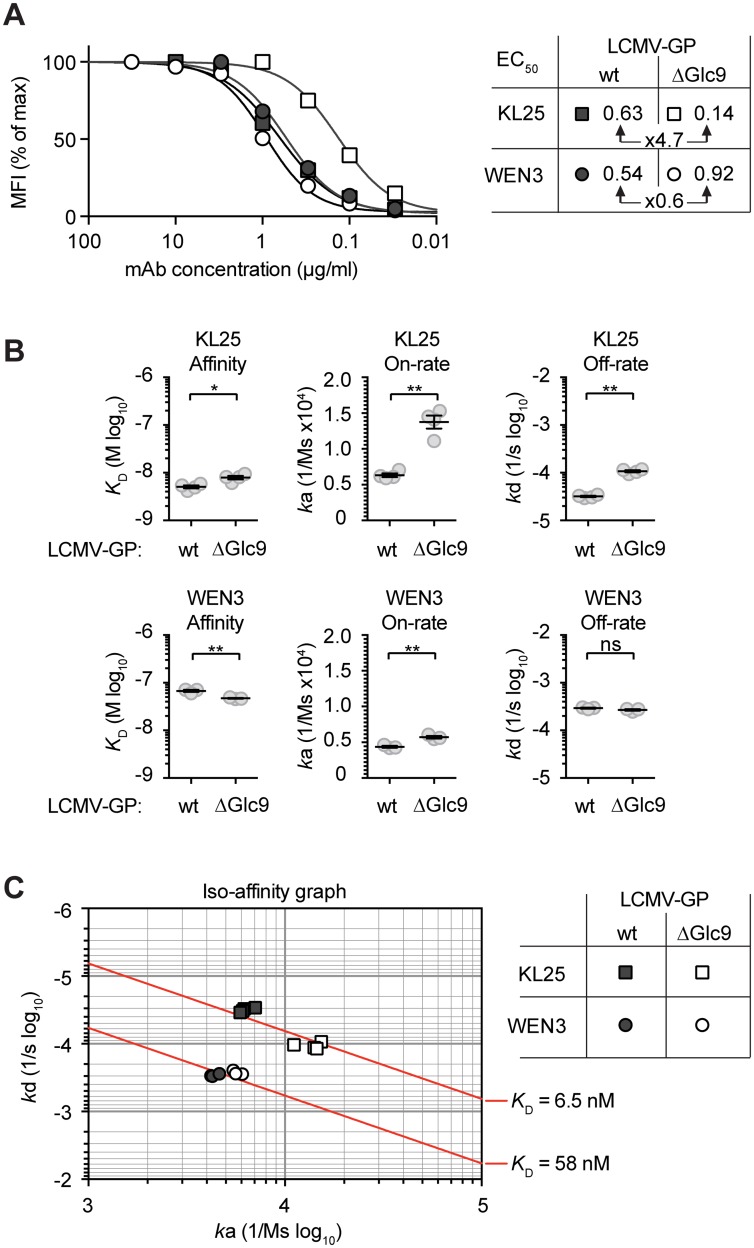
Facilitated binding of neutralizing mAb to Glc9-deficient LCMV-GP-1.(A) We transfected 293T cells with plasmids for expression of either LCMV-GPwt or LCMV-GPΔGlc9. We then incubated these cells with titrated concentrations of KL25 or WEN3 mAbs, and saturation of LCMV-GP binding was characterized by flow cytometry. The mean fluorescence intensity (MFI) is plotted as percentage of maximum staining intensity. Untransfected cells were used for reference. The 50% effective concentrations (EC50) are displayed in the chart. One out of two representative experiments is shown. (B-C) Binding kinetics of KL25 and WEN3 Fab fragments to LCMV-GPwt or LCMV-GPΔGlc9 were characterized by surface plasmon resonance (SPR). The association constant (ka), dissociation constant (kd) and the resulting equilibrium dissociation constant (K
D = kd/ka) were determined. Each measurement was done in triplicates for WEN3 and quadruplicates for KL25, respectively. In panel (B) means ± SEM are indicated. * p<0.05, ** p<0.01 by unpaired student’s t tests. (C) ka and kd values obtained by SPR were plotted on a two-dimensional graph such that identical KD values are located along iso-affinity lines (diagonals).